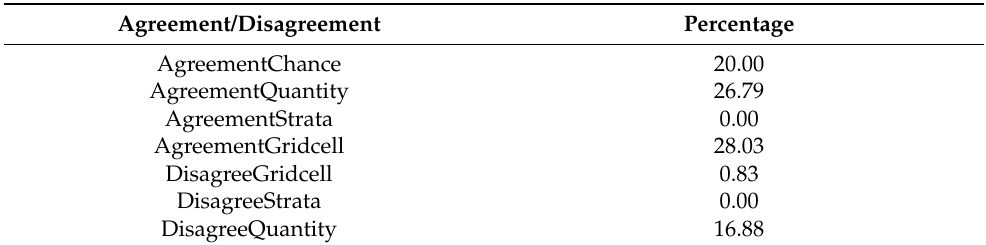
Table 5. Results of the agreement/disagreement classification analysis for reference and simulated. Source: Authors’ compilation.